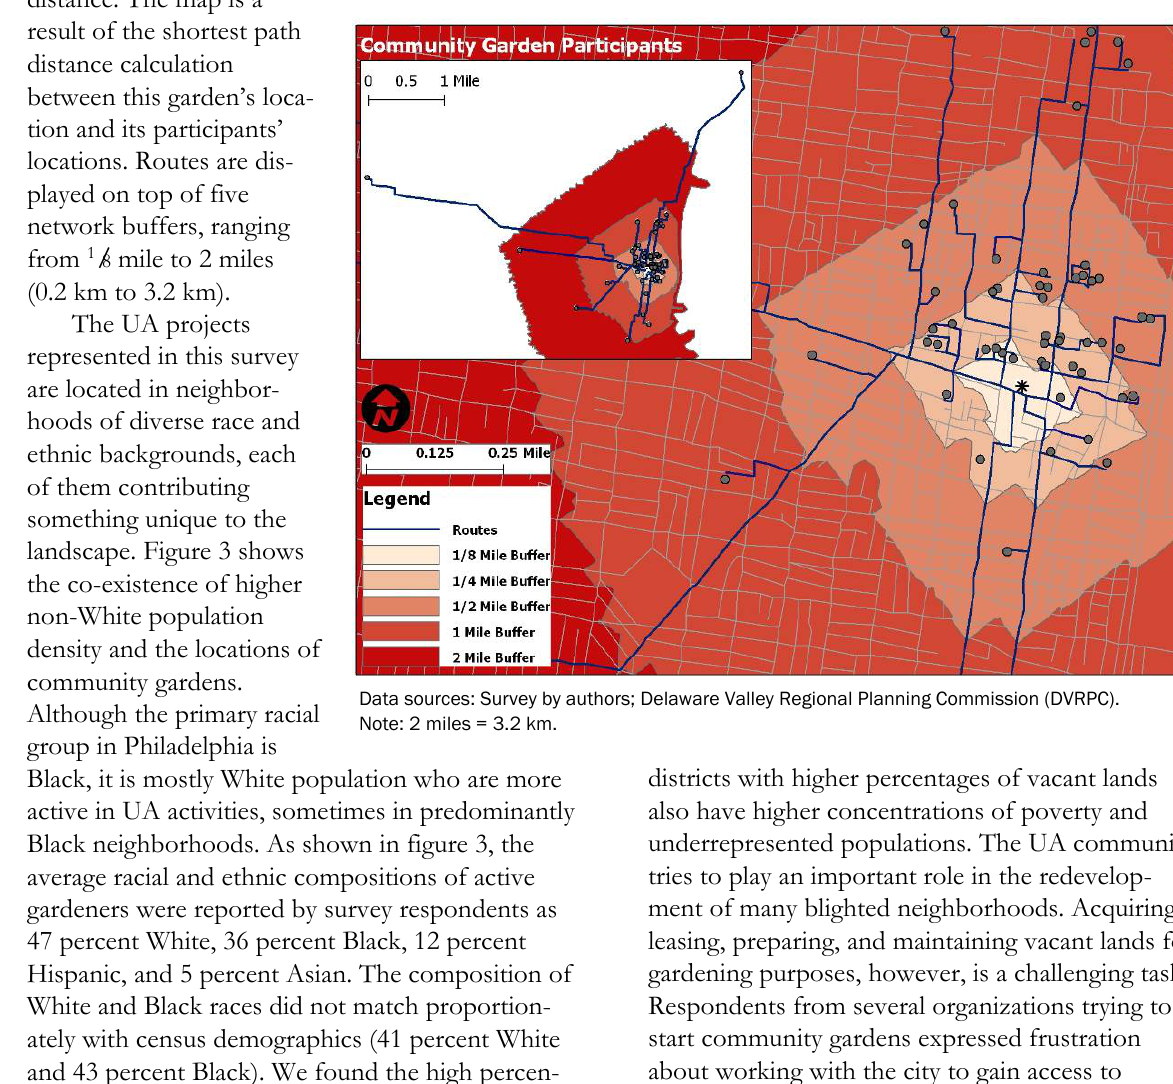
Figure 2. Locations of a South Philadelphia Community Garden and its